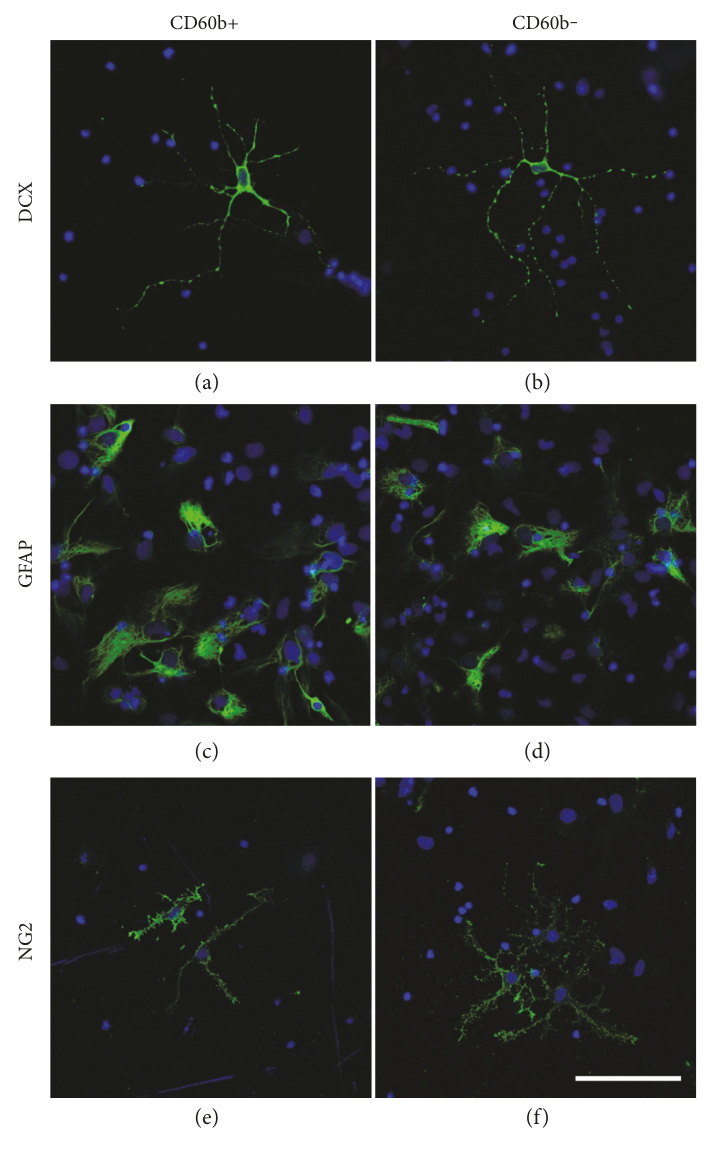
Figure 9: Di ff erentiation of neurospheres derived from CD60b-positive and CD60b-negative cells. Di ff erentiation of neurospheres originated from CD60b-positive and CD60b-negative E16 cells in DCX-positive neuroblasts (a-b), GFAP-positive astrocytes (c-d), and NG2-positive oligodendrocytes (e-f). We did not observe any clear di ff erences between di ff erentiated cells derived from neurospheres originated from CD60b-positive and CD60b-negative cells. Nuclei are stained with TO-PRO-3 in blue. Scale bar: 70 μ